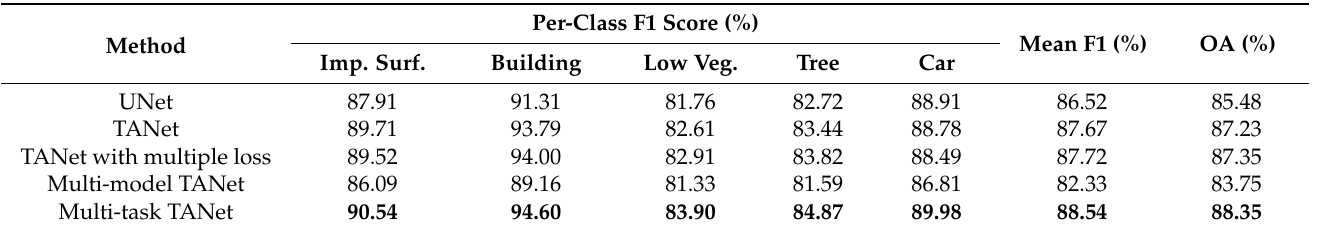
Table 4. F1 score, Mean F1, and OA index results of different models on Potsdam